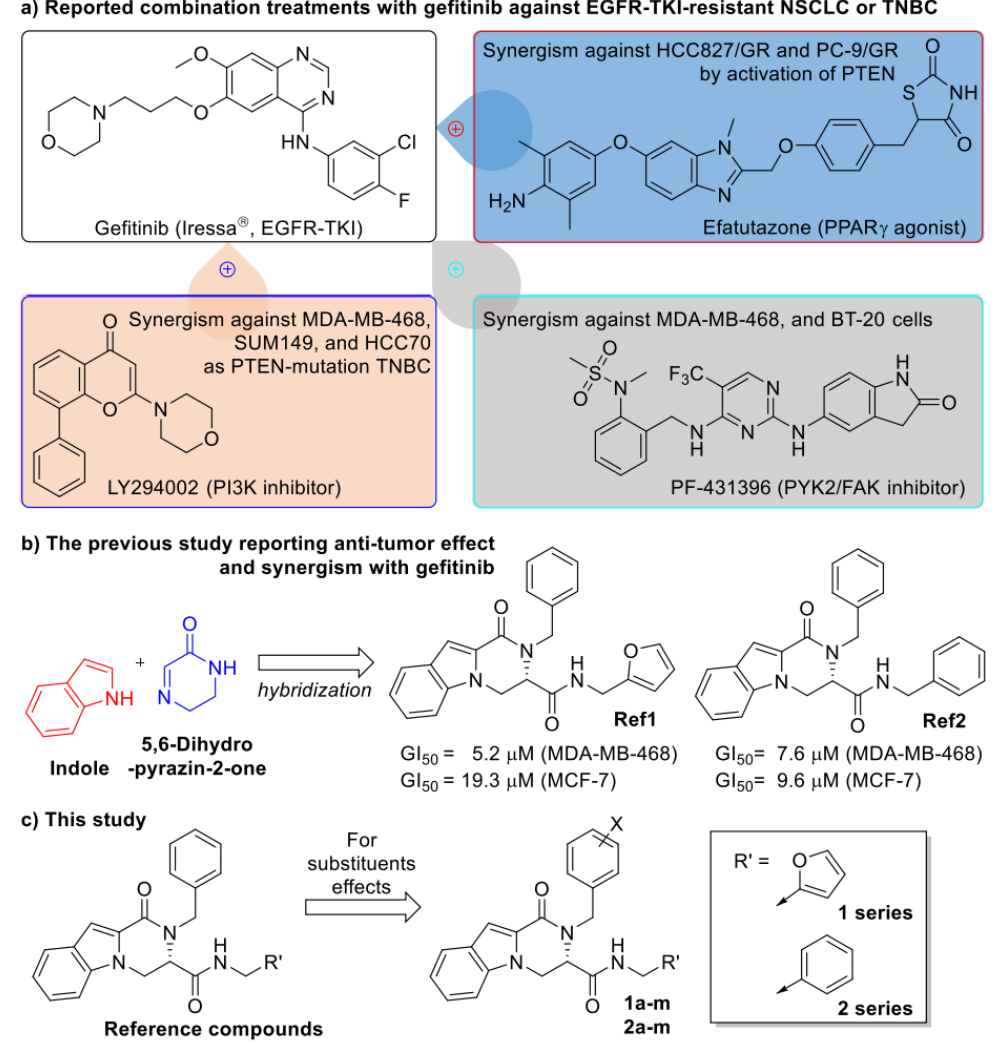
Figure 1. Reported compounds against EGFR-TKI-resistant cancer cell lines and design of pyrazino[1,2-a]indole-3-carboxamide. ( a ) compounds having synergistic effects with gefitinib; ( b ) the previous study of compounds Ref 1 and Ref 2; ( c ) proposal of novel pyrazino[1,2- a ]indole-3-carboxamide analogs based on the previous study.